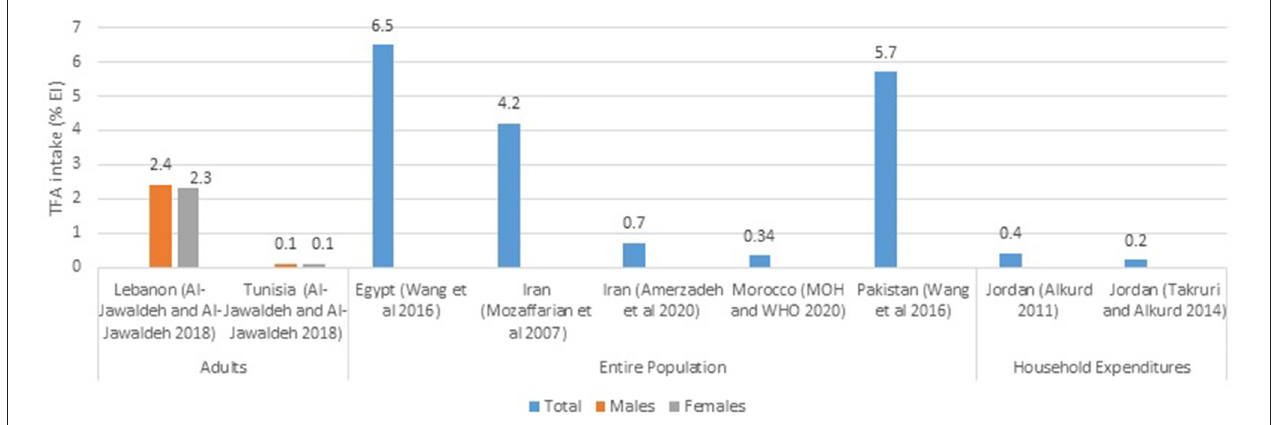
FIGURE 2 | TFA intake estimates (%EI) based on national studies in countries of the EMR. EI, energy intake; EMR, Eastern Mediterranean Region; MOH, Ministry of health; TFA, trans fatty acids; WHO, World Health Organization. References: For Adults: Lebanon and Tunisia (dietary assessment): Al-Jawaldeh and Al-Jawaldeh (14). For Entire Population: Egypt and Pakistan (dietary assessment): Wang et al. ( 4); Iran (dietary assessment): Mozaffarian et al. (39); Iran (consumption data): Amerzadeh and Takian ( 41); Morocco (consumption data): Ministry of Health-Morocco and World Health Organization (49). For Household Expenditures: Jordan: Alkurd (44) and Takruri and Alkurd ( 45).